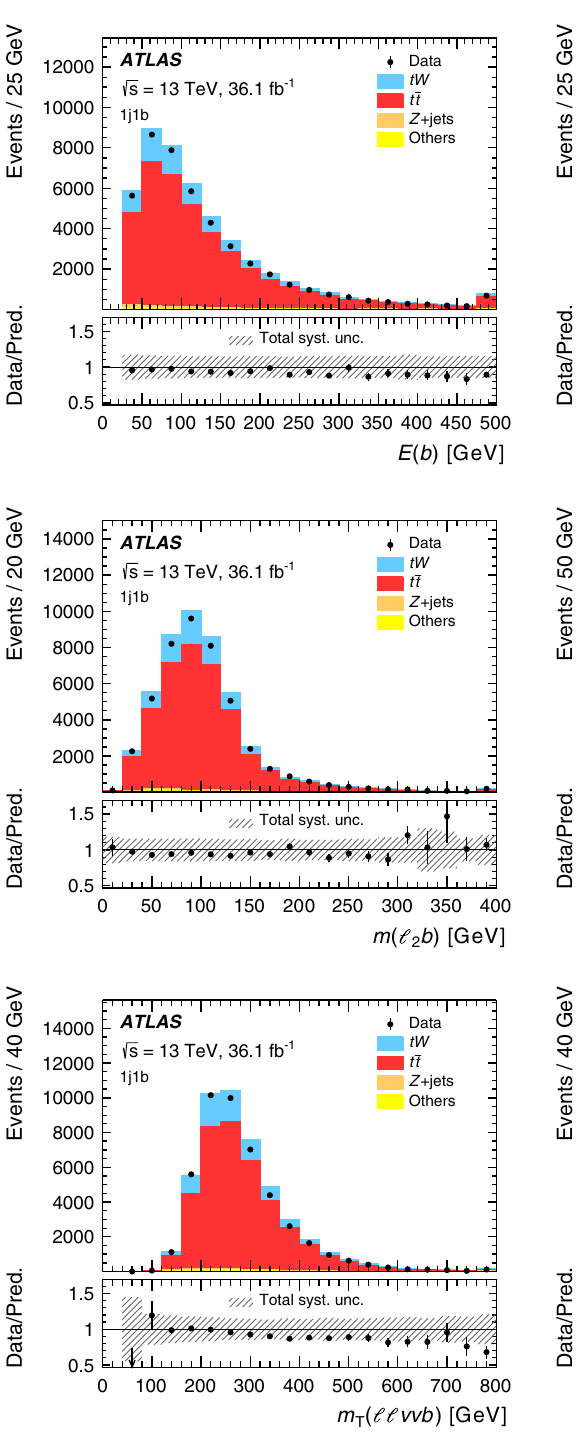
tainties in the MC predictions. The last bin of each distribution contains overflow events. The panels give the yields in number of events, and the ratios of the numbers of observed events to the total prediction in each bin and s 2 : (cid:10) p T ( s 1 , s 2 ) is the p T difference; and C ( s 1 s 2 ) is the ratio of the scalar sum of p T to the sum of energy, called the